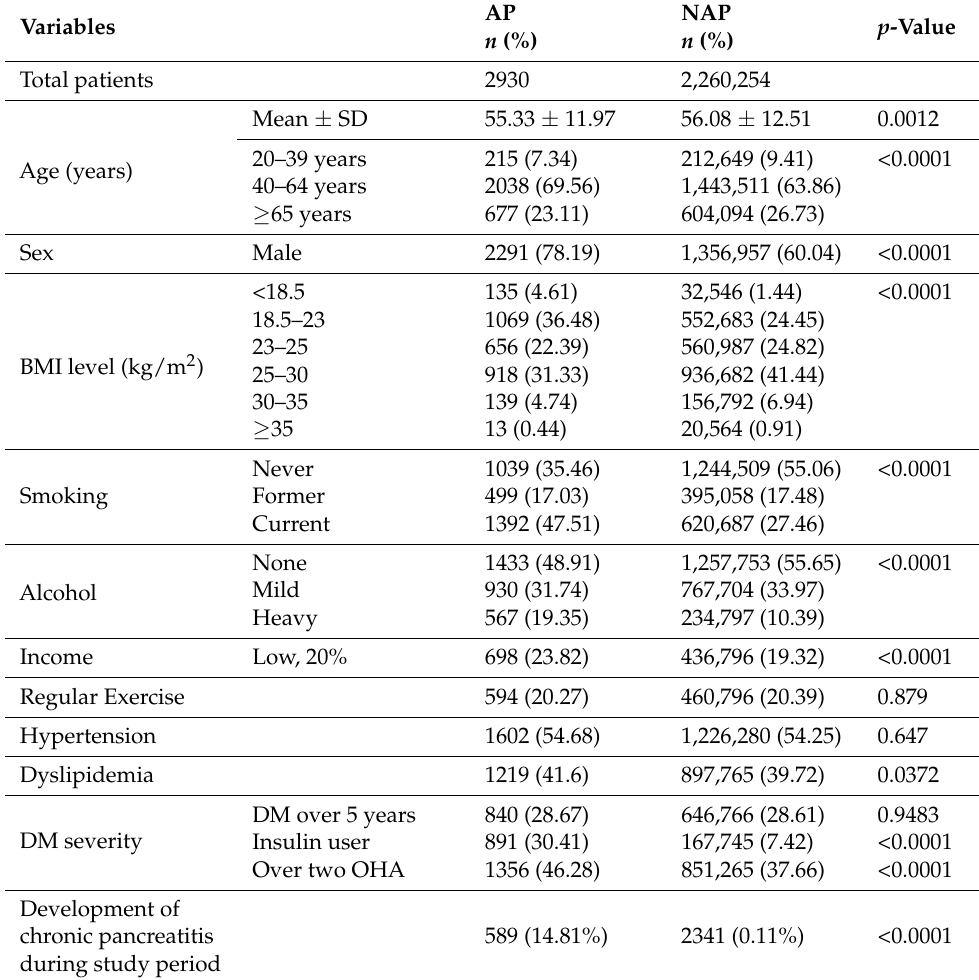
Table 1. Baseline characteristics of participants according to history of acute